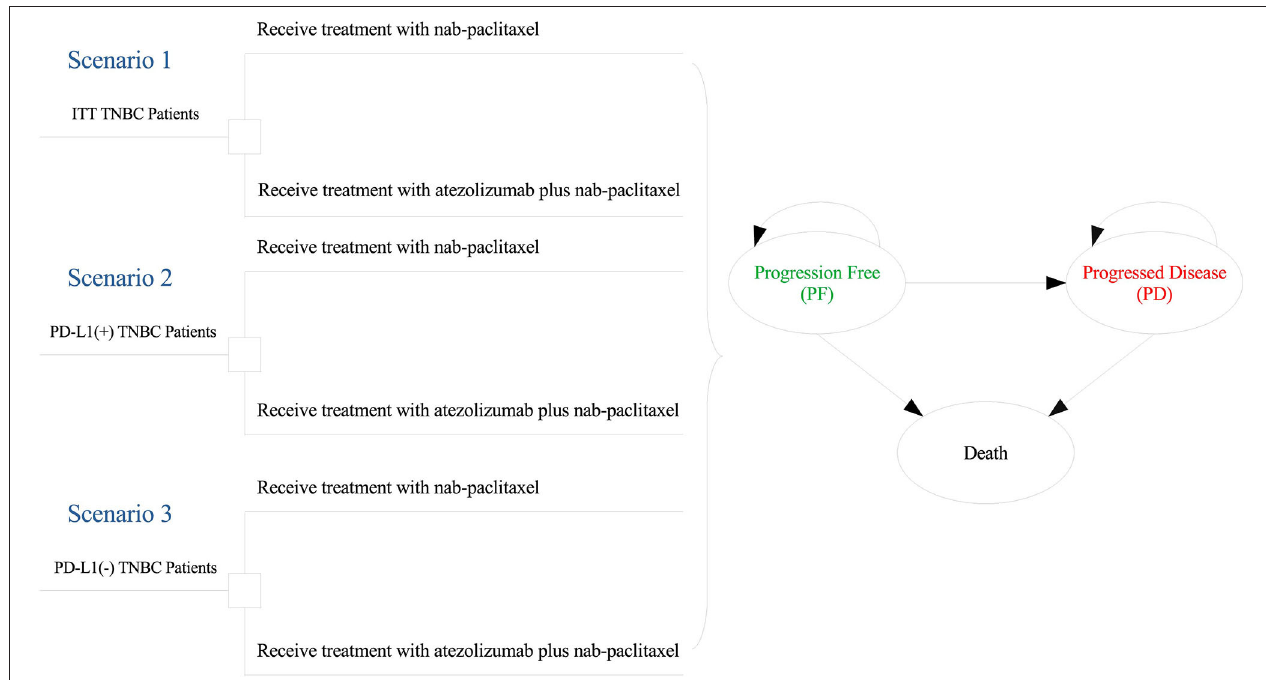
FIGURE 1 | Model structure overview. ITT, intention-to-treat; PD-L1, programmed death ligand-1; TNBC, triple-negative breast